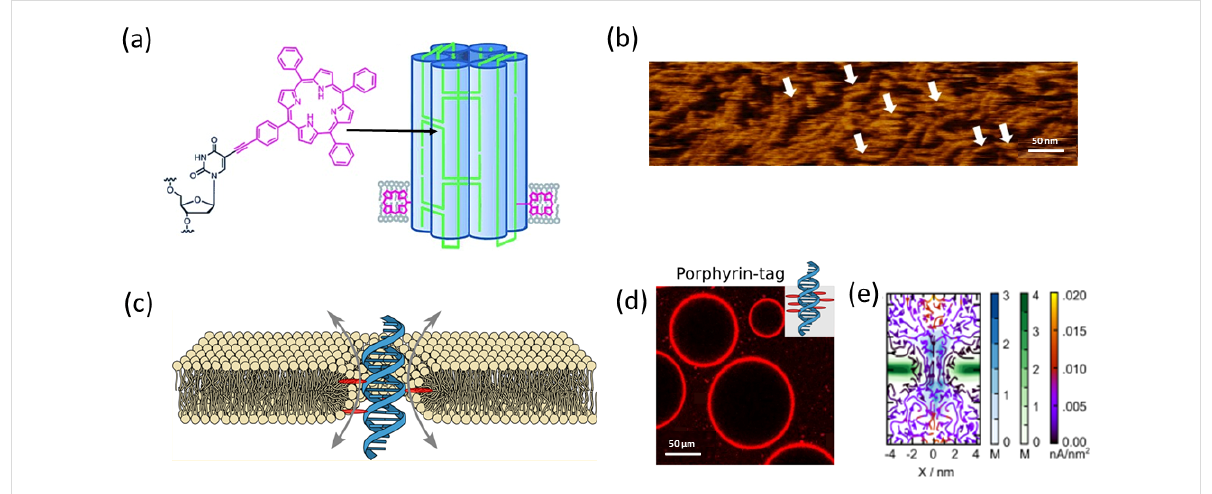
Figure 8: a) Schematic representation of a porphyrin-appended DNA nanopore base lipid anchor. b) AFM image of a nanopore assembly. c) Schematic design of a membrane-spanning porphyrin-tagged DNA duplex. d) Fluorescence confocal image highlighting the interaction of porphyrin- tethered DNA with lipid membrane. e) Molecular dynamics simulation to analyze steady-state local densities of porphyrin–DNA-anchored lipid chains and their current flow. Figure 8a and Figure 8b were adapted from [93], distributed under a Creative Commons Attribution license, copyright 2013